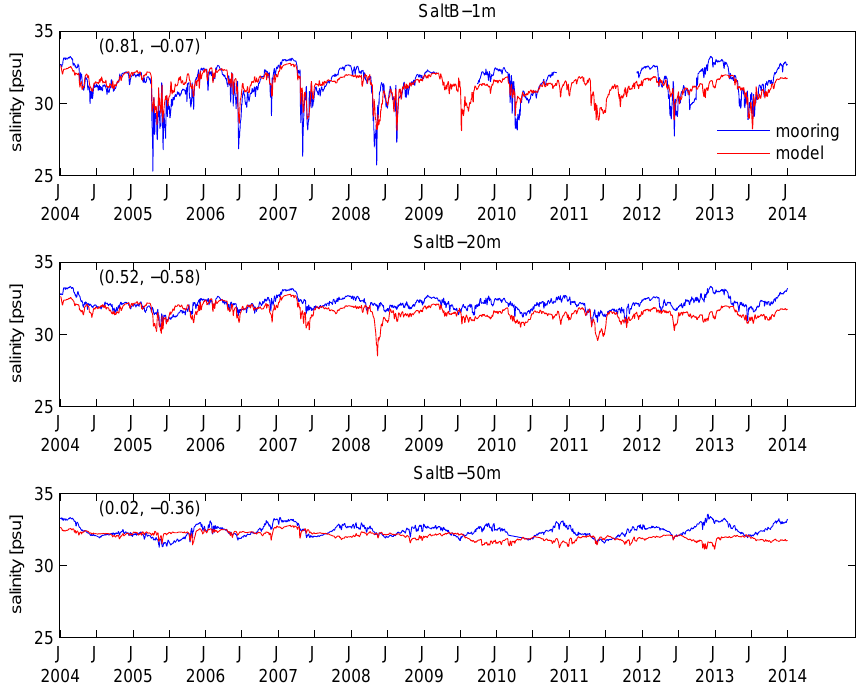
Figure 6. Comparison of observed (mooring) and simulated salinity time series at NERACOOS mooring B. Linear correlation coefficients ( r ) and mean bias ( b ) are shown in parentheses ( r , b ), respectively, in each panel.